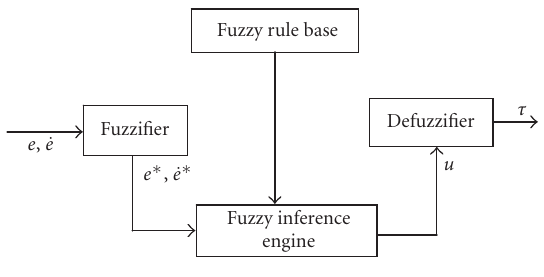
Figure 3: Membership functions of the linguistic